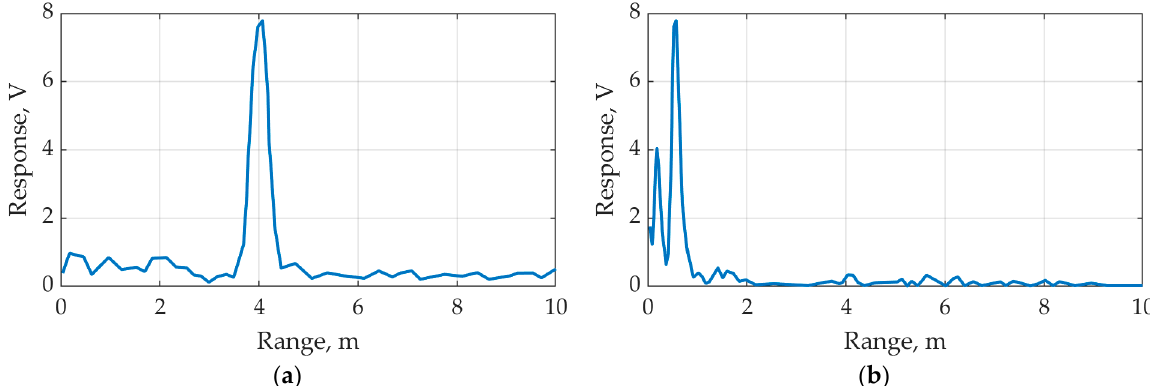
Figure 3. The response function of the target—A human facing the radar at a distance of 4 m: ( a ) in open space; ( b ) when sensing through a brick wall 0.5 m thick.